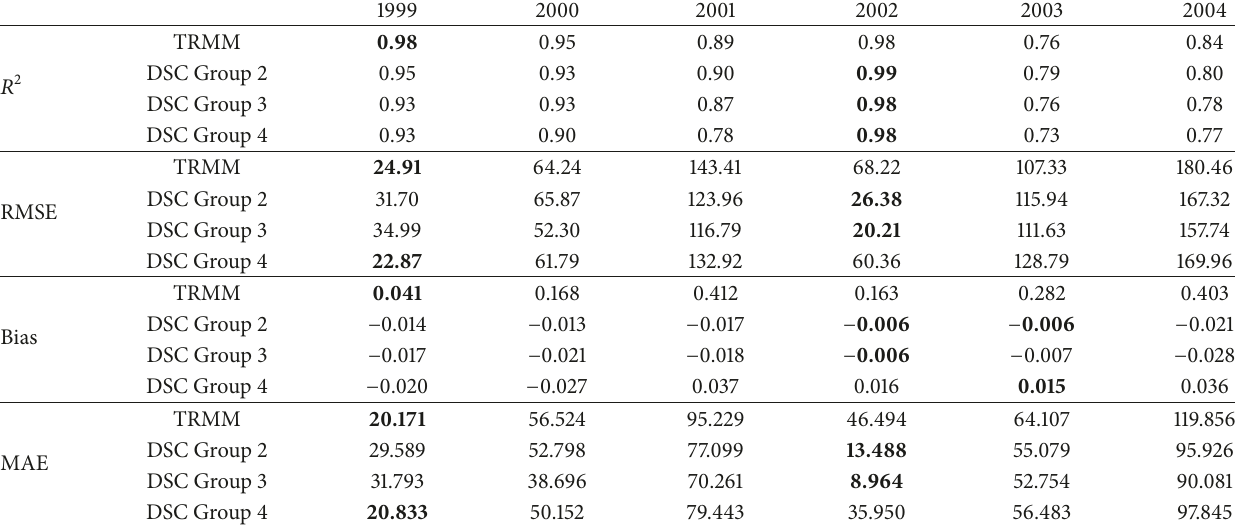
Table 5: Statistical metrics calculated based on measured precipitation from independent gauge stations for three groups of models (DSC: desegregated and calibrated